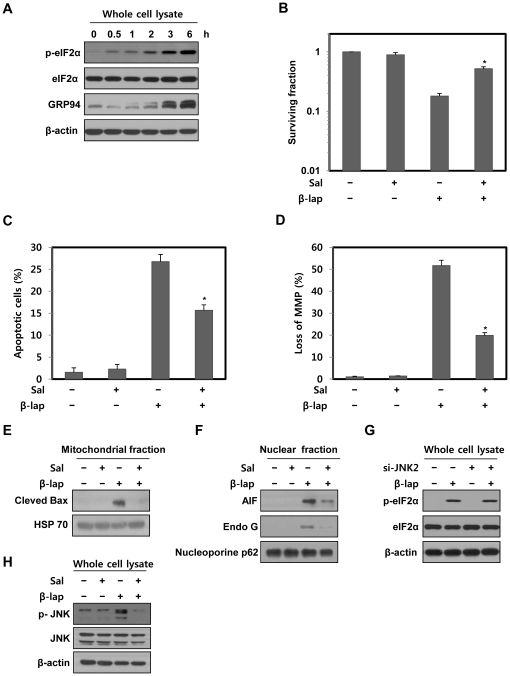
The induction of ER stress caused by β-lap is required for JNK activation.(A) NQO1+-MDA-MB-231 cells were treated with 5 µM of β-lap for the indicated times. Cell lysates were subjected to Western blot analysis with anti-phospho-eIF2α, -eIF2α, -GRP94 and β-actin antibodies. β-actin was used as a loading control. The data represent a typical experiment conducted three times with similar results. (B) NQO1+-MDA-MB-231 cells were treated with 5 µM of β-lap in the presence or absence of Salubrinal (30 µM). Cells were allowed to grow for 10 to 14 days and were stained with 0.5% crystal violet and scored for colony formation. Results from three independent experiments are expressed as means ± SEM. *Significant difference between cells in the presence or absence of Salubrinal after β-lap treatment, at p<0.05. (C) NQO1+-MDA-MB-231 cells were treated with 5 µM of β-lap for 18 h in the presence or absence of Salubrinal (30 µM). Cells were stained with PI and the percentage of cells with a sub-G1 DNA content was measured via flow cytometric analysis. Results from three independent experiments are expressed as the means ± SEM. *Significant difference between the cells in the presence or absence of Salubrinal after β-lap treatment at p<0.05. (D) NQO1+-MDA-MB-231 cells were treated with 5 µM of β-lap for 6 h in the presence or absence of Salubrinal (30 µM). Cells were loaded with 30 nM of DiOC6(3) for a further 30 min of the treatments. After removal of medium, the concentration of retained DiOC6(3) was measured by flow cytometry. Results from three independent experiments are expressed as means ± SEMs. *Significant difference between the cells in the presence or absence of Salubirnal after β-lap treatment at p<0.05. (E) NQO1+-MDA-MB-231 cells were treated with 5 µM of β-lap for 6 h in the presence or absence of Salubrinal (30 µM). Mitochondrial fractions were prepared and subjected to Western blot analysis using anti-Bax and -mitochondrial HSP70 antibodies. Mitochondrial HSP70 was used as a mitochondrial marker protein. The data are representative a typical experiment conducted three times. (F) NQO1+-MDA-MB-231 cells were treated with 5 µM of β-lap for 6 h in the presence or absence of Salubrinal (30 µM). Nuclear fractions were prepared and subjected to Western blot analysis using anti-AIF, -Endo G, and -Nucleoporin p62 antibodies. Nucleoporin p62 was used as a nuclear marker protein. The data are representative a typical experiment conducted three times. The data are representative of a typical experiment conducted three times with similar results. (G) NQO1+-MDA-MB-231 cells transfected with JNK2 siRNA were treated with 5 µM of β-lap for 3 h. Cell lysates were subjected to Western blot analysis with anti-phospho-eIF2α, -eIF2α and -β-actin antibodies. β-actin was used as a loading control. The data represent a typical experiment conducted three times with similar results. (H) NQO1+-MDA-MB-231 cells were treated with 5 µM of β-lap for 30 min in the presence or absence of Salubrinal (30 µM). Cell lysates were subjected to Western blot analysis with anti-phospho-JNK1/2, -JNK1/2, and -β-actin antibodies. β-actin was used as a loading control. The data represent a typical experiment conducted three times with similar results.